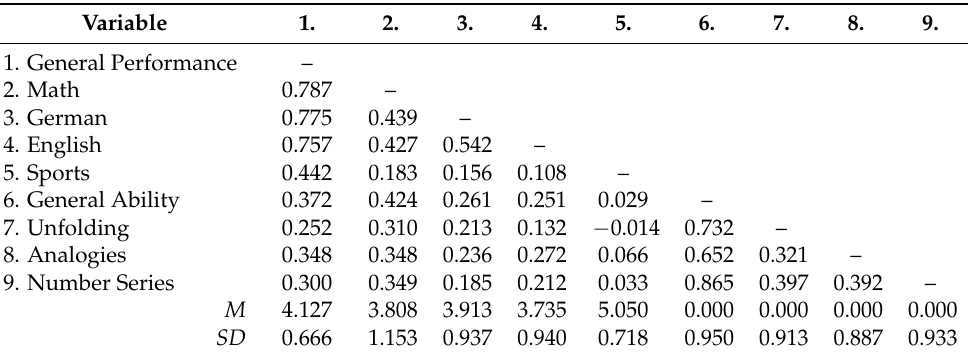
Table 1. Descriptive statistics for the overall sample ( N =